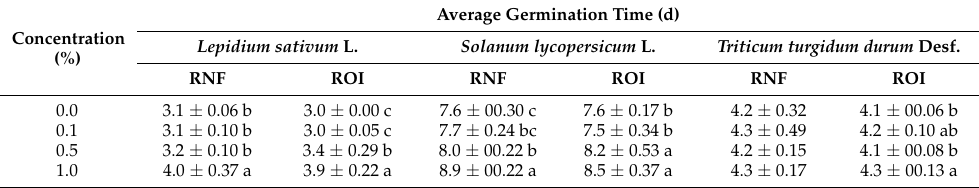
Table 4. Effects of different concentrations of retentates on average germination time of cress, tomato, and durum wheat (1).